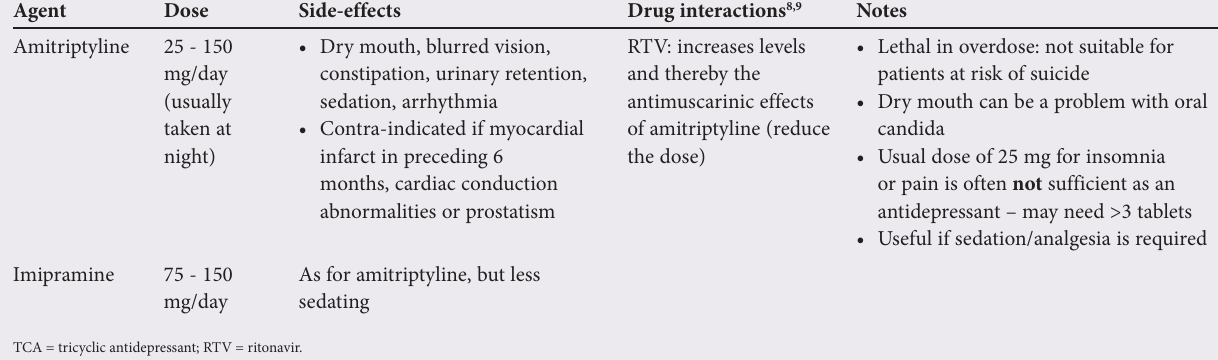
Table 3. Side-effects, drugs interactions and advantages of concurrent TCA use with ART Agent